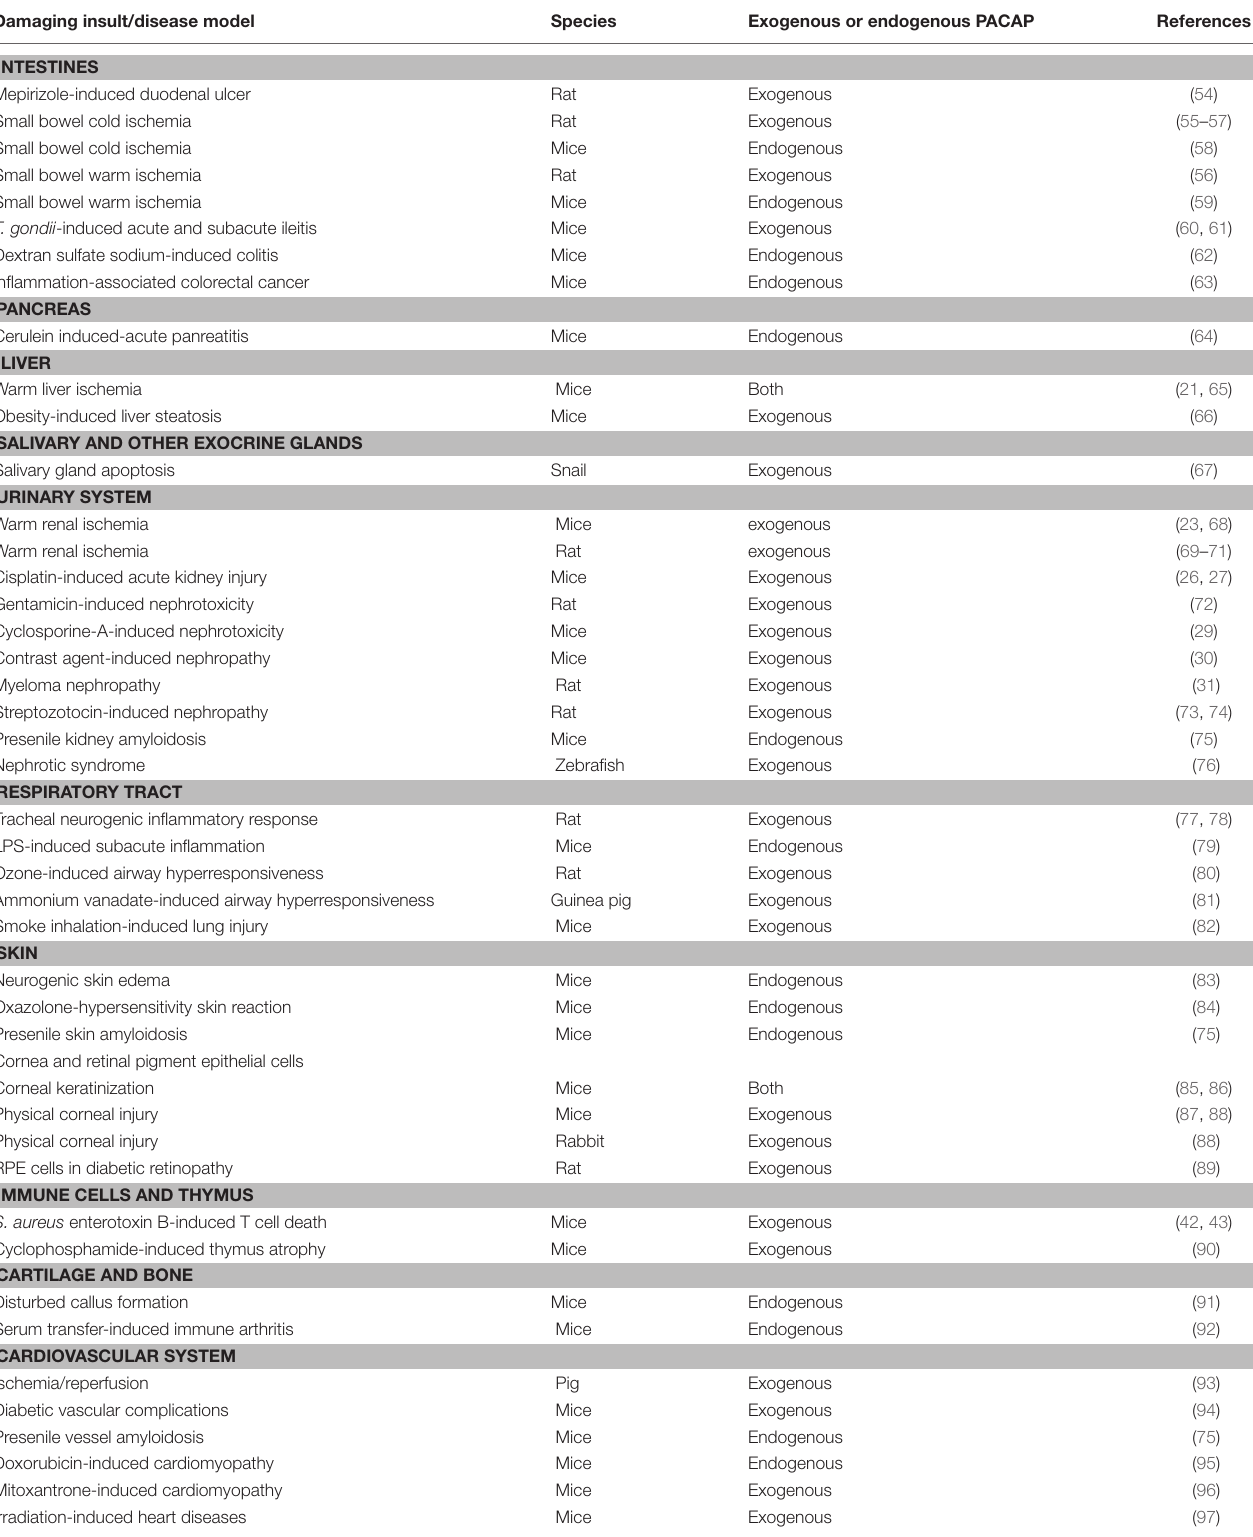
TABLE 2 | In vivo studies showing protective effects of endogenous or exogenous PACAP. Damaging insult/disease